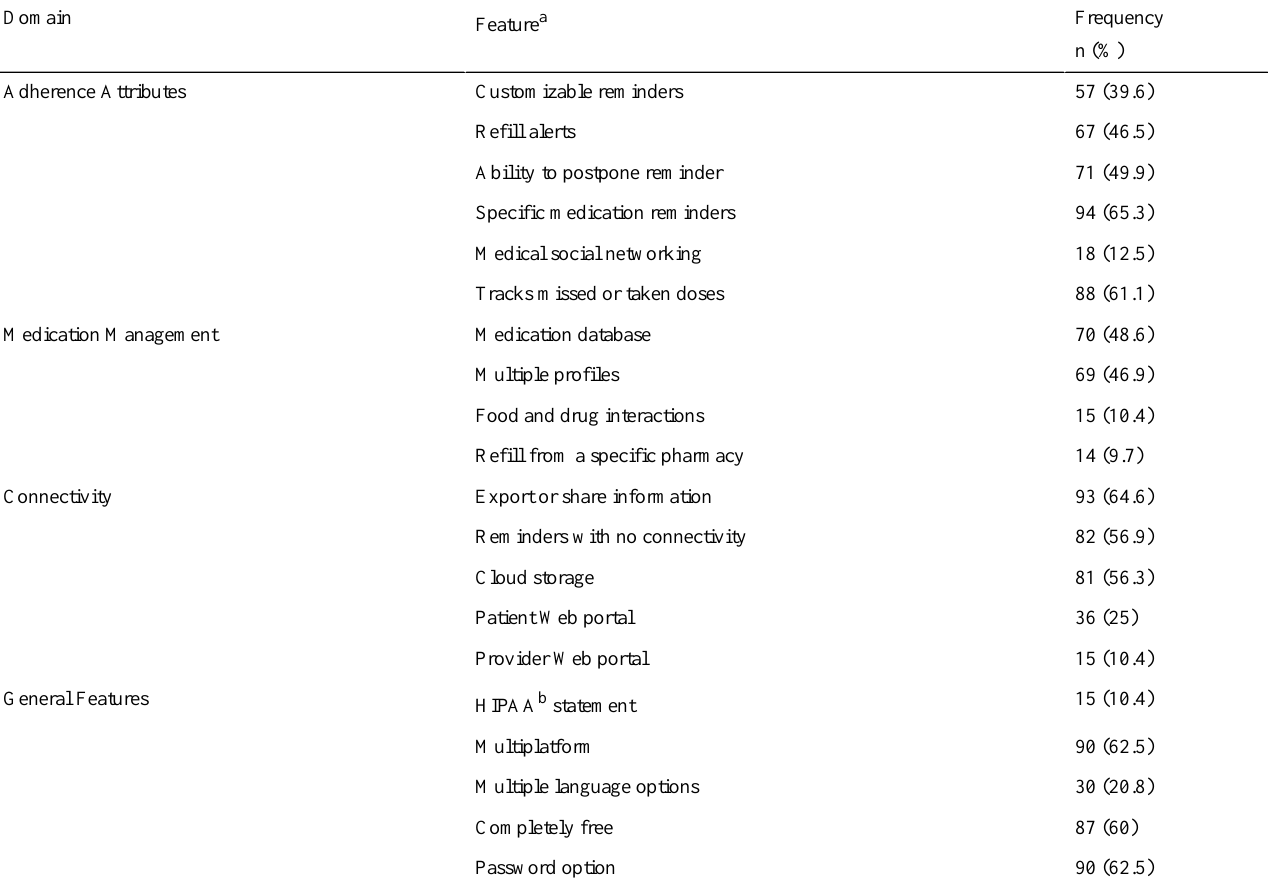
Table 1. Select adherence app feature frequencies based on user testing (max N=144).